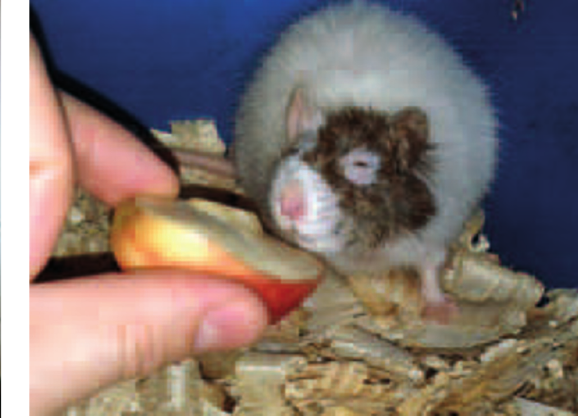
Figure 11. A recipient rat 2 month